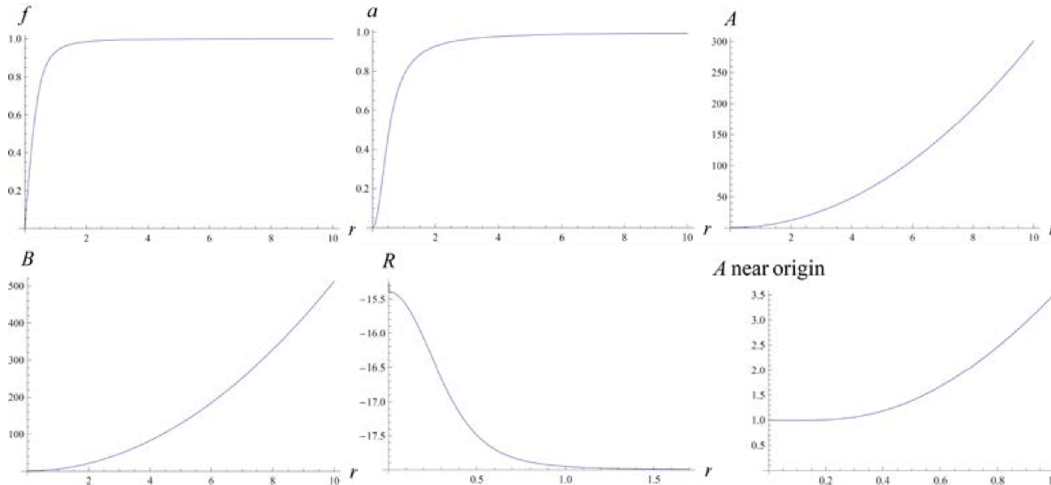
Figure 3 . Case III: n = 1 , v = 1 and Λ = − 3 . The Ricci scalar plateaus at − 18 in agreement with the value 6Λ . The matter profile f here is more compressed (the core is smaller) than in the two previous cases and it has the greatest mass of the